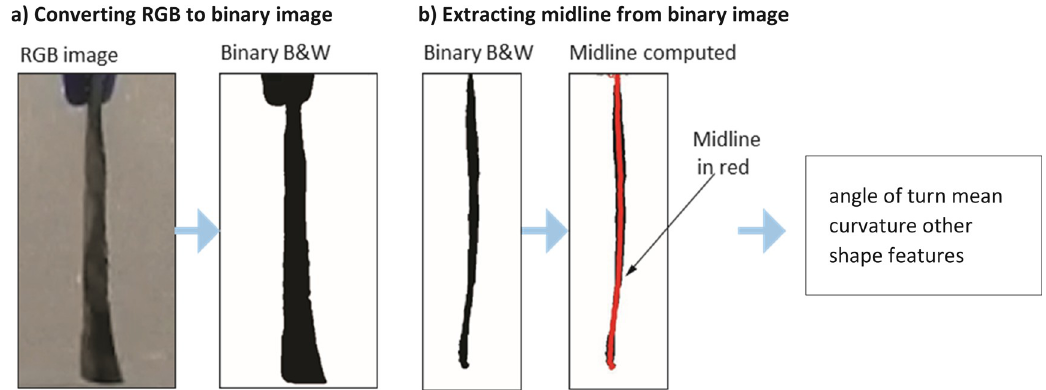
Fig 2. Image processing and computer vision. Some steps in the automatic analysis of the video are outlined. (A) RGB images from the video frames are converted to binary black and while images. (B) Binary images are processed to extract a contiguous midline through the filament. This midline path is then used to determine shape features such as angle of turn, curvature, etc.